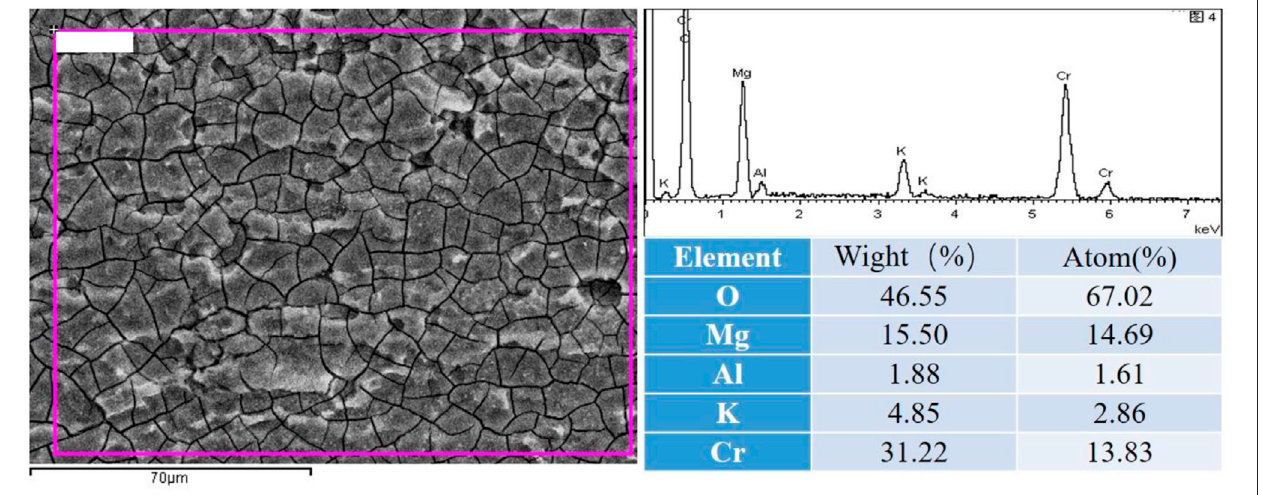
FIGURE 1 | The morphology and element content of the fi